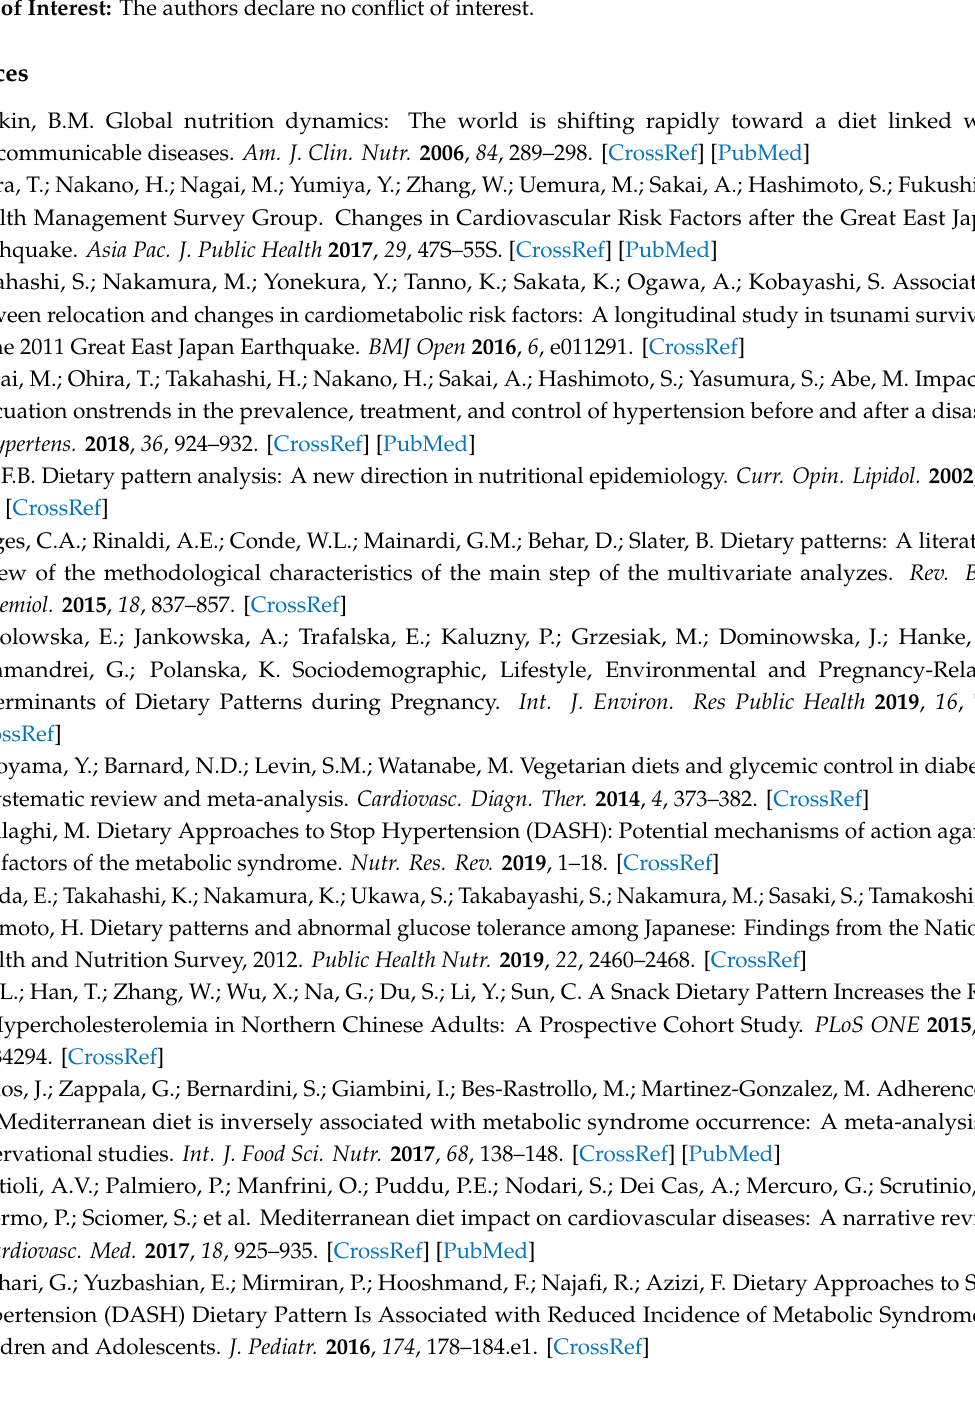
Figure S1. Flowchart for 2014 and 2015 study participants, Fukushima Health Management Survey. Table S1. Cumulative mean scores of dietary patterns during 2011–2013 by cardiometabolic factors in 2014, Fukushima Health Management Survey. Table S2. Cumulative mean scores of dietary patterns during 2011–2013 by cardiometabolic factors in 2015, Fukushima Health Management